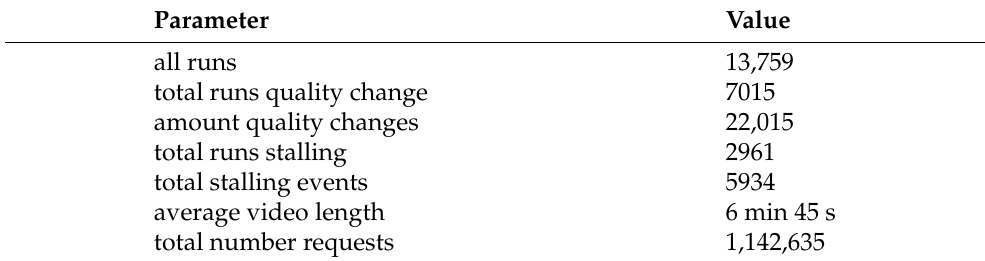
Table 4. General dataset